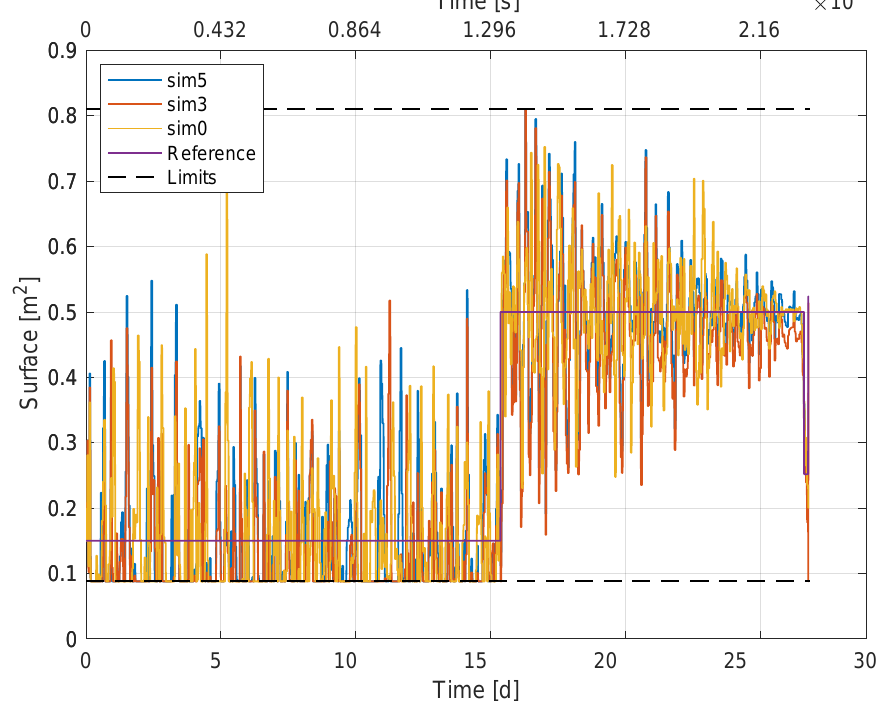
Figure 8. Optimized control law for the de-orbiting phase. The bottom axis displays the time scale in days, while the upper axis shows it in